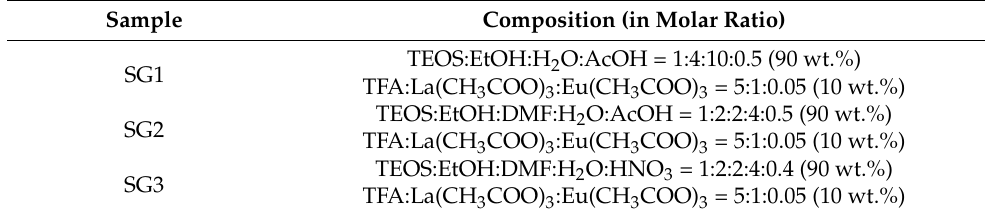
Table 2. The components of fabricated Eu 3+ -doped sol-gel materials.